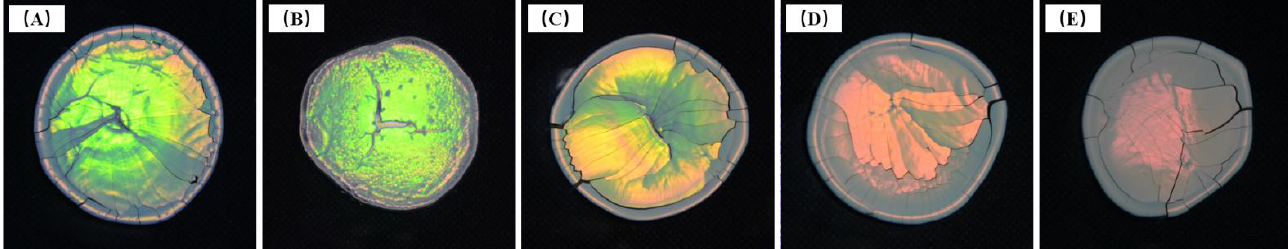
Figure 5. FE-SEM images of P(St-AA) colloidal microspheres synthesized with different APS amounts: ( A ) 125 mg; ( B ) 150 mg; ( C ) 175 mg; ( D ) 200 mg; ( E ) 225 mg. ( A ) 125 mg; ( B ) 150 mg; ( C ) 175 mg; ( D ) 200 mg; ( E ) 225 mg.